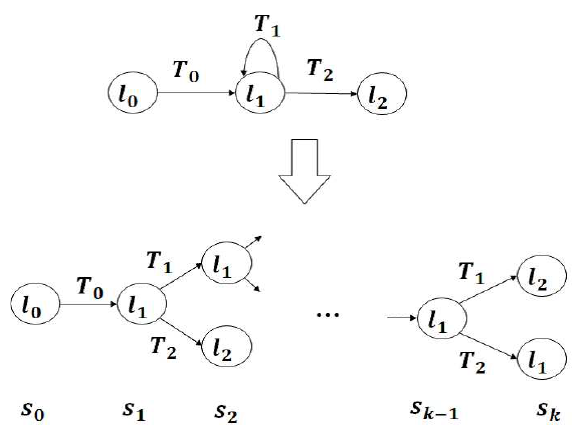
Figure 1. Unrolling the system from Control Flow Graph